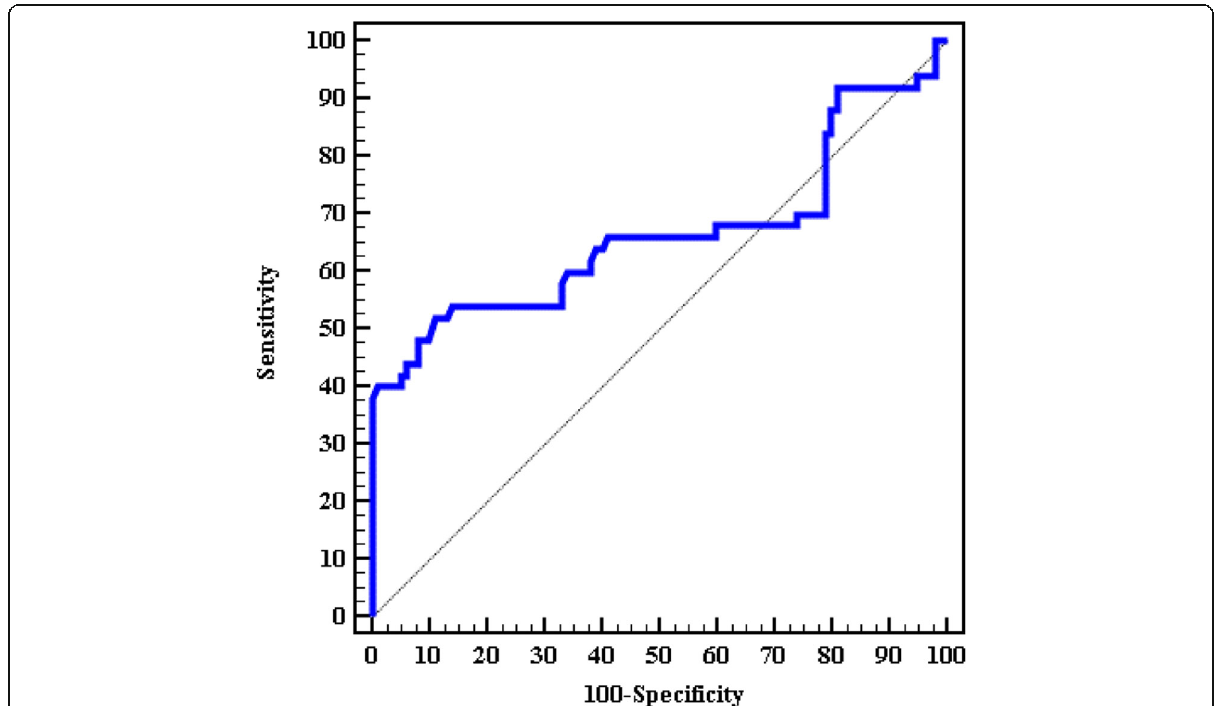
Fig. 1 ROC curve for AFP (ng/ml) to predict early-stage HCC patients (group II) from HCV-related cirrhosis (group I)